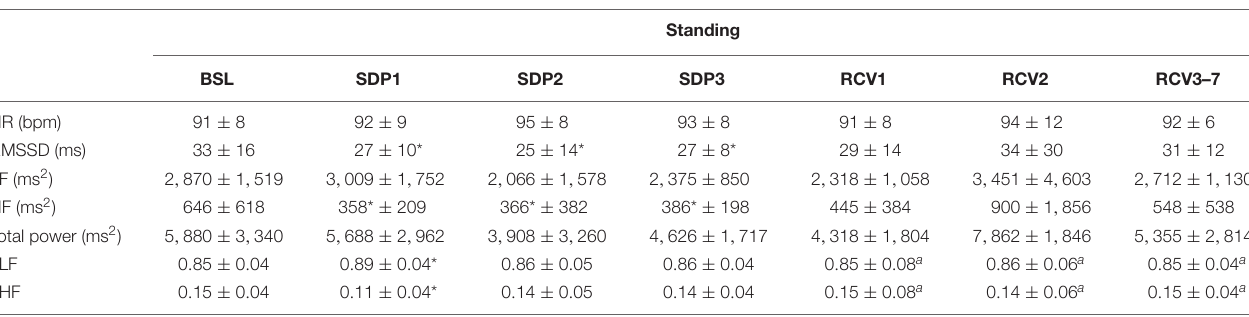
TABLE 2 | Heart rate variability (HRV) parameters in standing position.